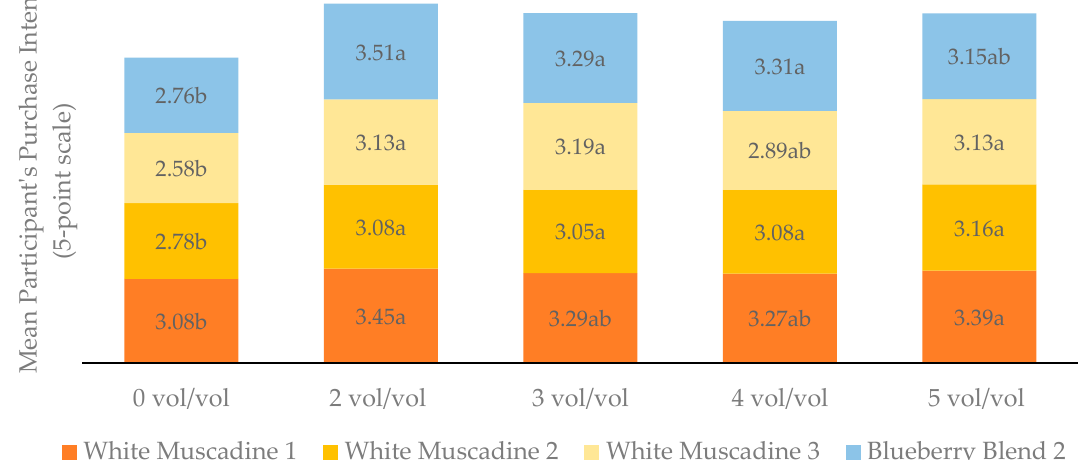
Figure 3. The average purchase intent using a 5-point hedonic scale from each panel for four Florida wines. a, b denotes statistical significance ( p < 0.05) for each individual carbonation level for each wine.